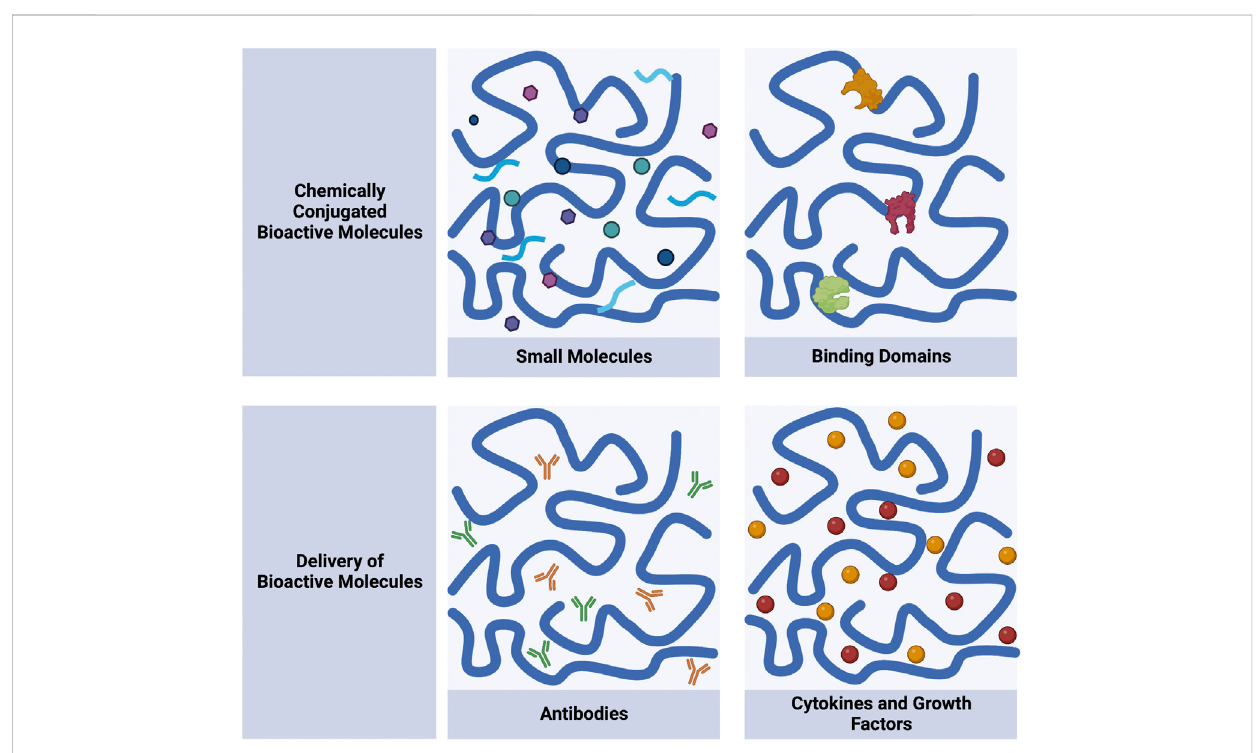
FIGURE 1 Self-assemblingpeptidescanbedesignedtochemicallyconjugateanddeliverbioactivemolecules.Chemicallyconjugatedmoleculesincludesmall